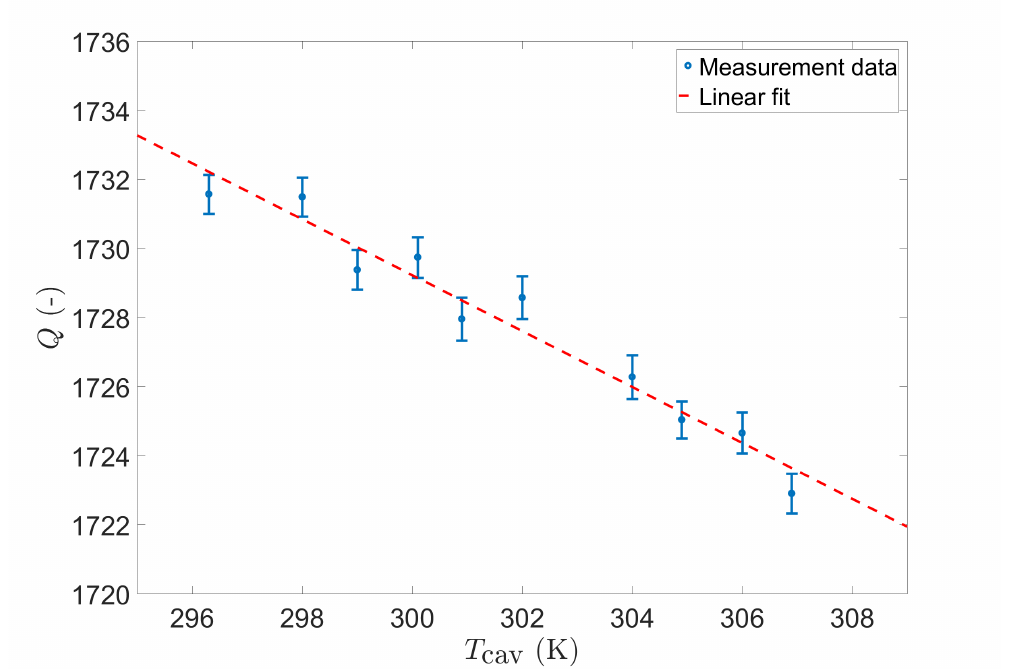
Figure 11. The quality factor Q as a function of the temperature of the metal structure surrounding the cavity T cav . The circles represent the measurement data and the dashed line is obtained by a linear fit procedure using the experimental